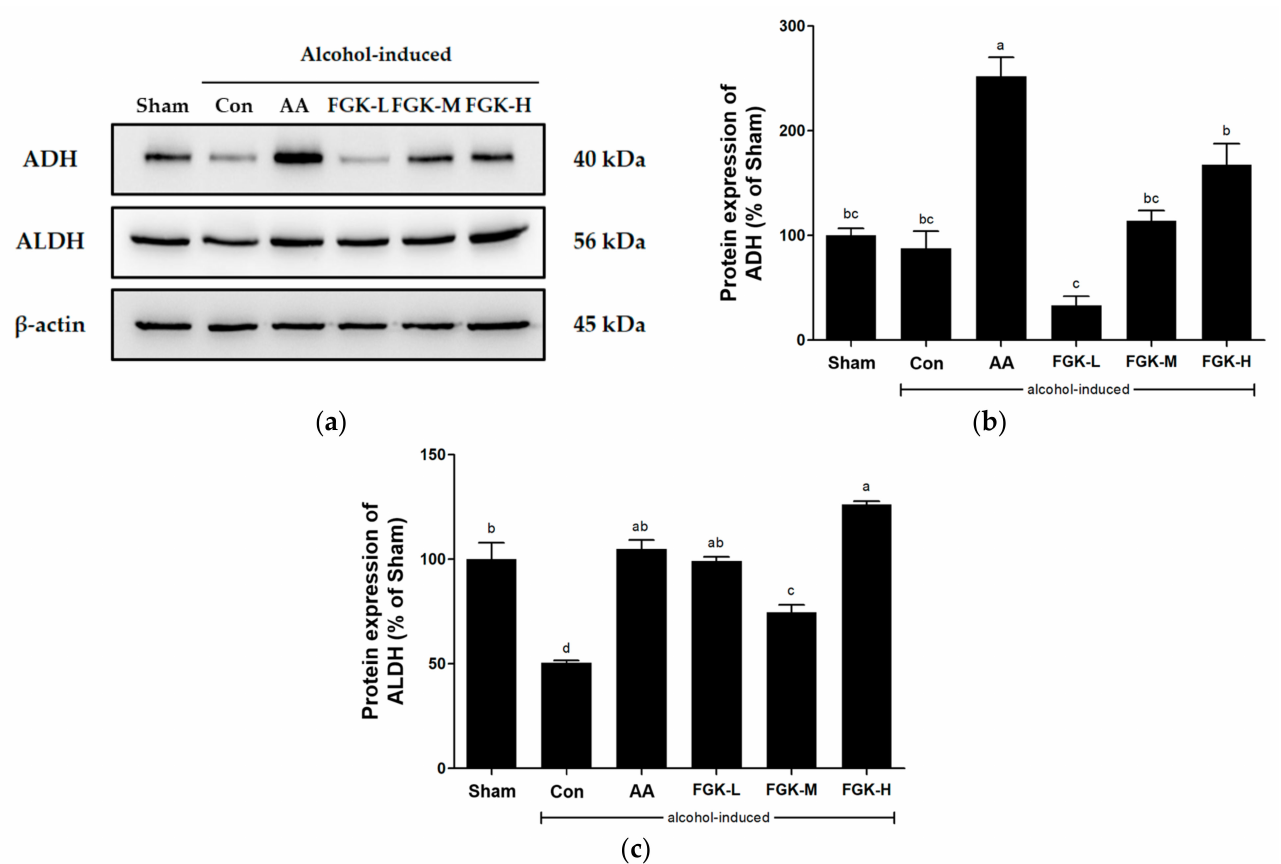
Figure 4. Effects of fermented gold kiwi (FGK) on liver alcohol metabolism in alcohol-induced mice. ( a ) Protein expression; ( b ) alcohol dehydrogenase (ADH); ( c ) aldehyde dehydrogenase (ALDH). Sham, mice treated with only saline; Con, mice treated with alcohol and saline; AA, mice treated with alcohol and ascorbic acid (25 mg/kg); FGK-L, -M, -H, mice treated with alcohol and FGK at 50, 126, and 250 mg/kg, respectively. Results expression as means ± SEM ( n = 8). a–d Different letters indicate significant differences ( p < 0.05) among the groups, as determined by Tukey’s